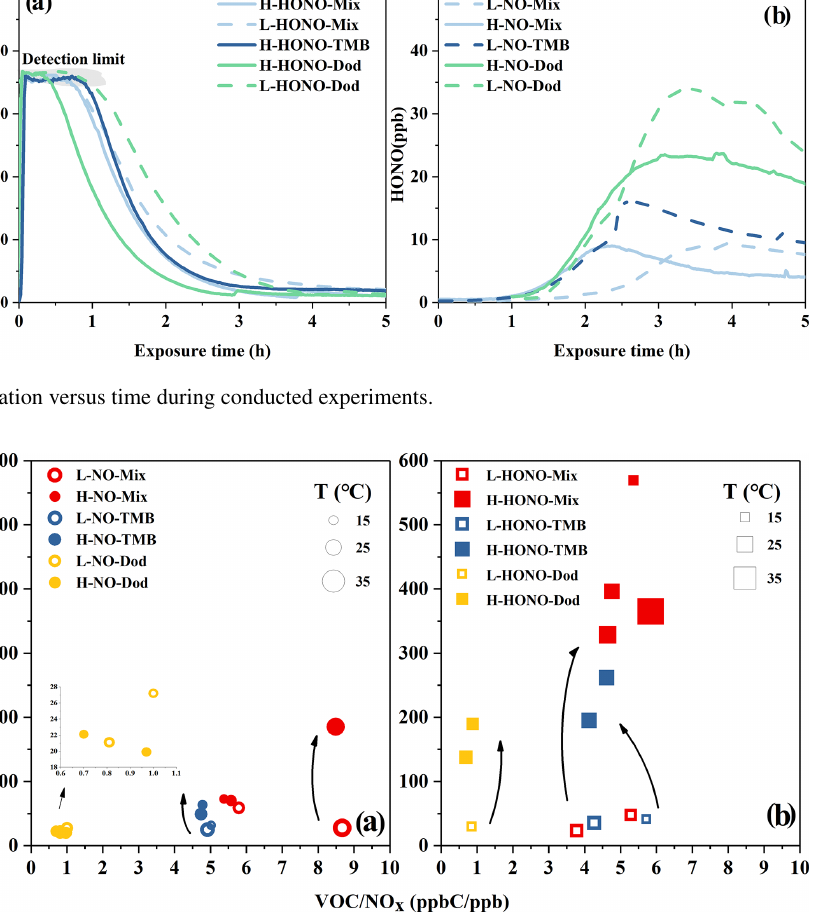
Figure 5. Particle formation of NO and HONO experiments. The temperature ( T ) and particle mass concentration here refer to the maximum value during the reaction process. The yellow circles refer to NO-Dod experiments with low SO 2 concentration, and the yellow filled circles refer to NO-Dod experiments with high SO 2 concentration. The blue circles refer to NO-TMB experiments with low SO 2 concentration, and the blue filled circles refer to NO-TMB experiments with high SO 2 concentration. The red circles refer to NO-Mix experiments with low SO 2 concentration, and the red filled circles refer to NO-Mix experiments with high SO 2